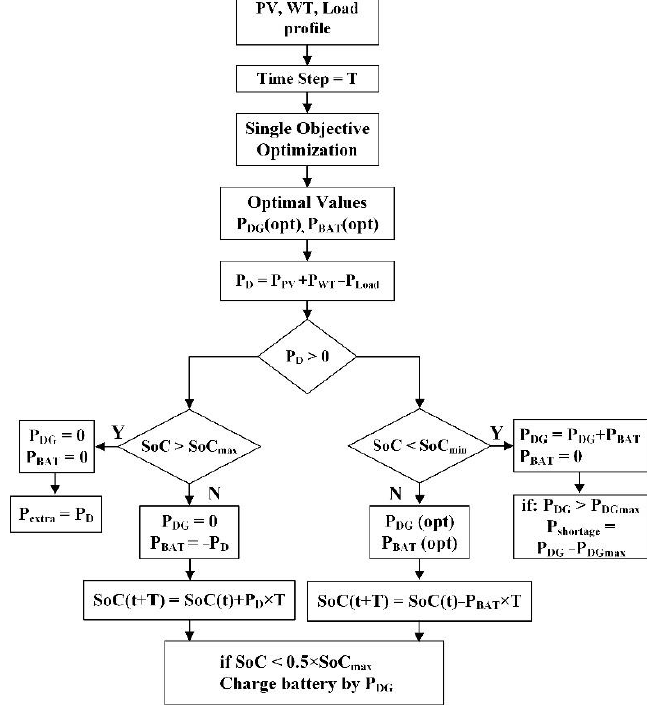
Figure 3. Power management algorithm for the HIMG.